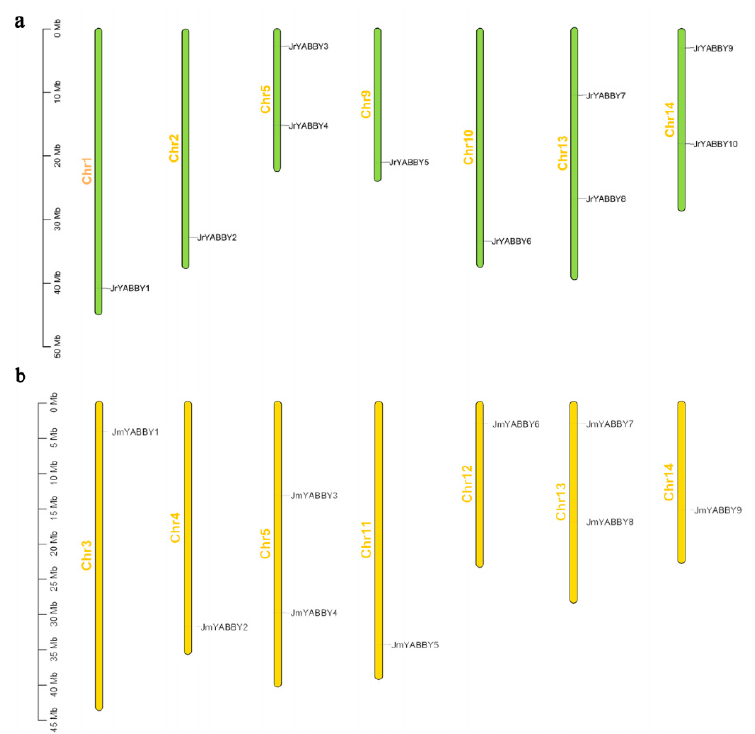
Figure 3. Chromosomal distribution of YABBY genes. ( a ) Chromosomal distribution of YABBY genes in J. regia . ( b ) Chromosomal distribution of YABBY genes in J. mandshurica . Chromosome numbers are shown below each chromosome. Black, JrYABBY genes, JmYABBY genes. Green, J. regia chromosomes; Yellow, J. mandshurica chromosomes. Table 2. Four duplicated types of YABBY genes in J. regia and J. mandshurica .